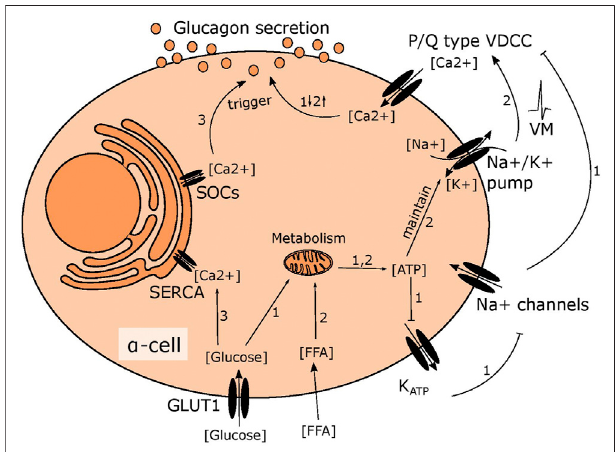
FIGURE 1 | Suggested mechanisms of glucose induced changes in glucagon secretion. 1) In high glucose conditions, glucose is metabolised in mitochondria leading to higher ATP levels. This fully closes the K ATP channel, depolarising the membrane slightly to inhibit the voltage gated sodium channel.ThispreventsopeningofP/QtypeVDCCs,limitingcalciumin fl uxand inhibiting glucagon secretion. 2) Fatty acid metabolism fuels the sodium potassium pump in low glucose, maintaining the membrane potential to allow action potential fi ring and activation of P/Q type VDCCs, resulting in stimulation of glucagon secretion 3) ER calcium stores are emptied in low glucose due to SOCs channel opening, triggering glucagon secretion. When glucose levels rise, this is reversed as the SERCA pump transports calcium from the cytosol into the